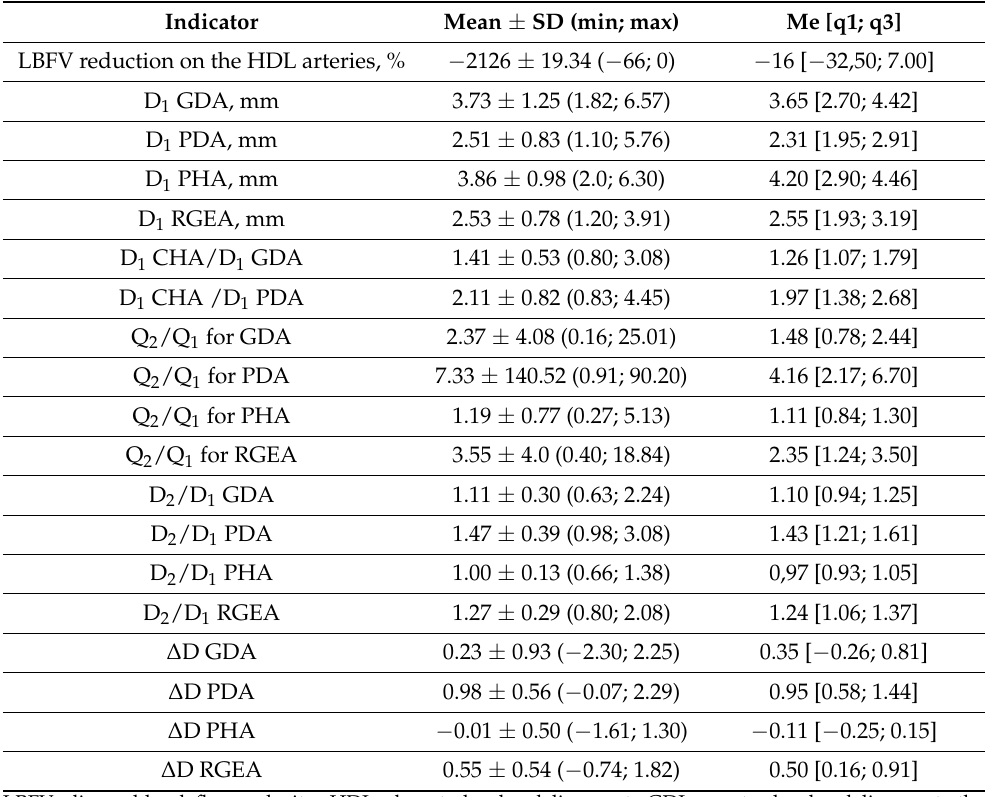
Table 6. Relative changes in the arterial geometry and blood flow intensity after DP